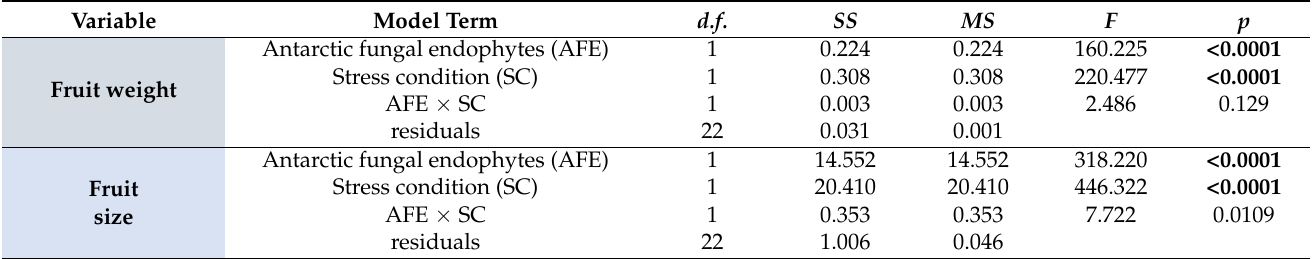
Figure 2. Effects of fungal endophyte inoculation (E+ or E − ) and environmental condition (cold without water deficit (Cold/W+) or cold and water deficit (Cold/W − )) on survival dynamics of blueberry plants ( Vaccinum corymbosum , cv Briggita). Different letters indicate different pairwise survival trends ( p > 0.05), as estimated by the Gehan–Wilcoxon test. Table 2. Two-way analysis of variance (ANOVA) testing the effect of the presence/absence of two Antarctic fungal endophytes (AFE+ or AFE − ) and the stress condition (cold without water deficit [Cold/W+] or cold and water deficit [Cold/W − ]) on size (mm) and weight (g) of fruits blueberry plants ( Vaccinum corymbosum , cv Briggita). Significant factor effects ( p < 0.05) are highlighted in bold, d.f. : degrees of freedom; SS : sum of squares; MS : mean squares, F : F statistic; p : probability